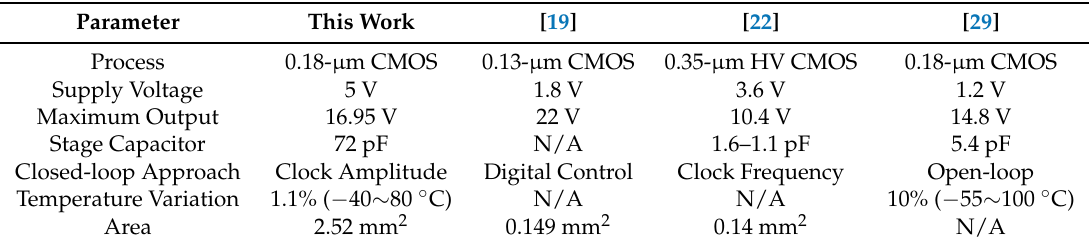
Table 1. Performance comparison with previous